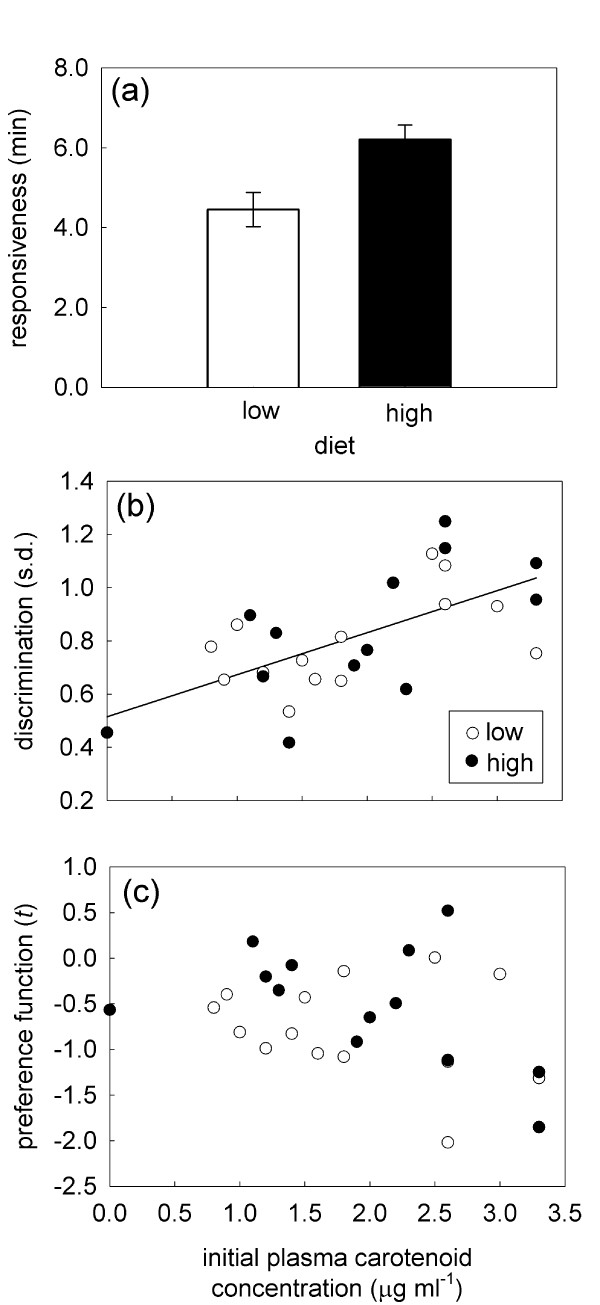
The components of female choice in relation to diet and plasma carotenoid levels. (a) Mean ± s.e. mate responsiveness of high- and low-carotenoid females. (b) Scatterplot illustrating the relationship between female mate discrimination and plasma carotenoid levels prior to carotenoid supplementation. (c) Scatterplot showing the female preference functions and plasma carotenoid levels prior to carotenoid supplementation. Open symbols represent the low-carotenoid females and closed symbols represent the high-carotenoid females.